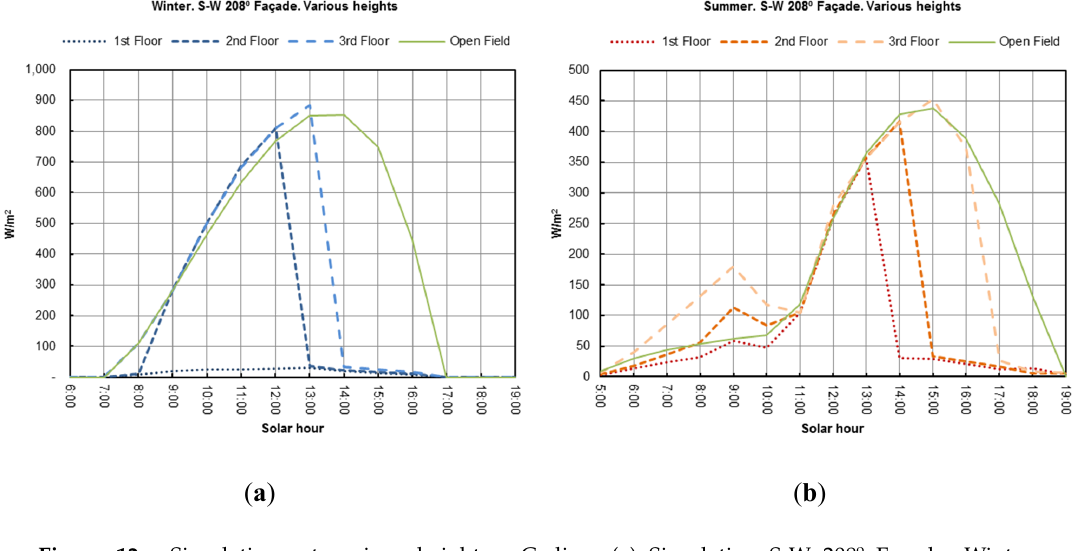
Figure 12. Simulations at various heights. Cadiz. ( a ) Simulation S-W 208º Façade, Winter; ( b ) Simulation S-W 208º Façade, Summer.